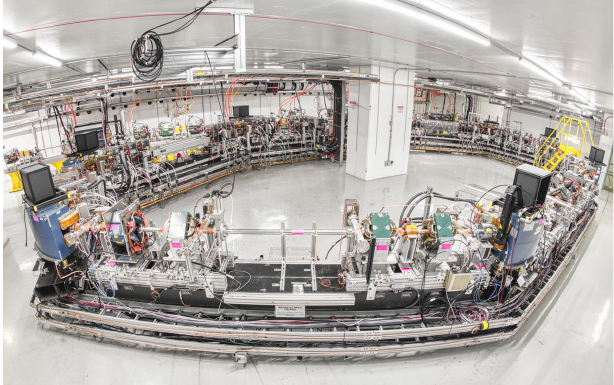
FIG. 4. Fermilab ’ s IOTA ring for beam physics research.